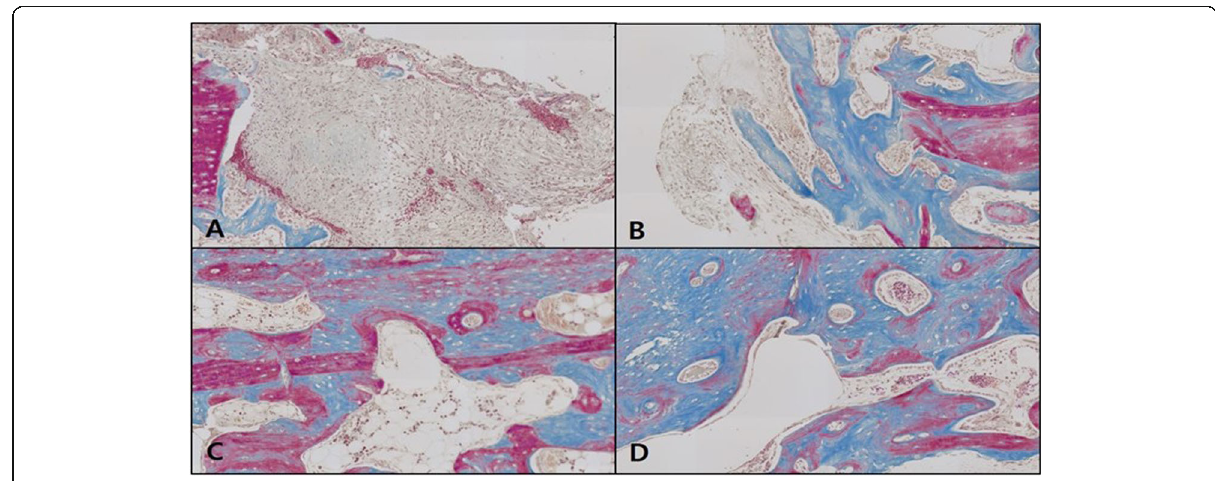
Fig. 10 Microphotograph at 1 week ( A ), 2 weeks ( B ), 4 weeks ( C ), and 6 weeks ( D ) after bone graft in control rabbit. Masson.